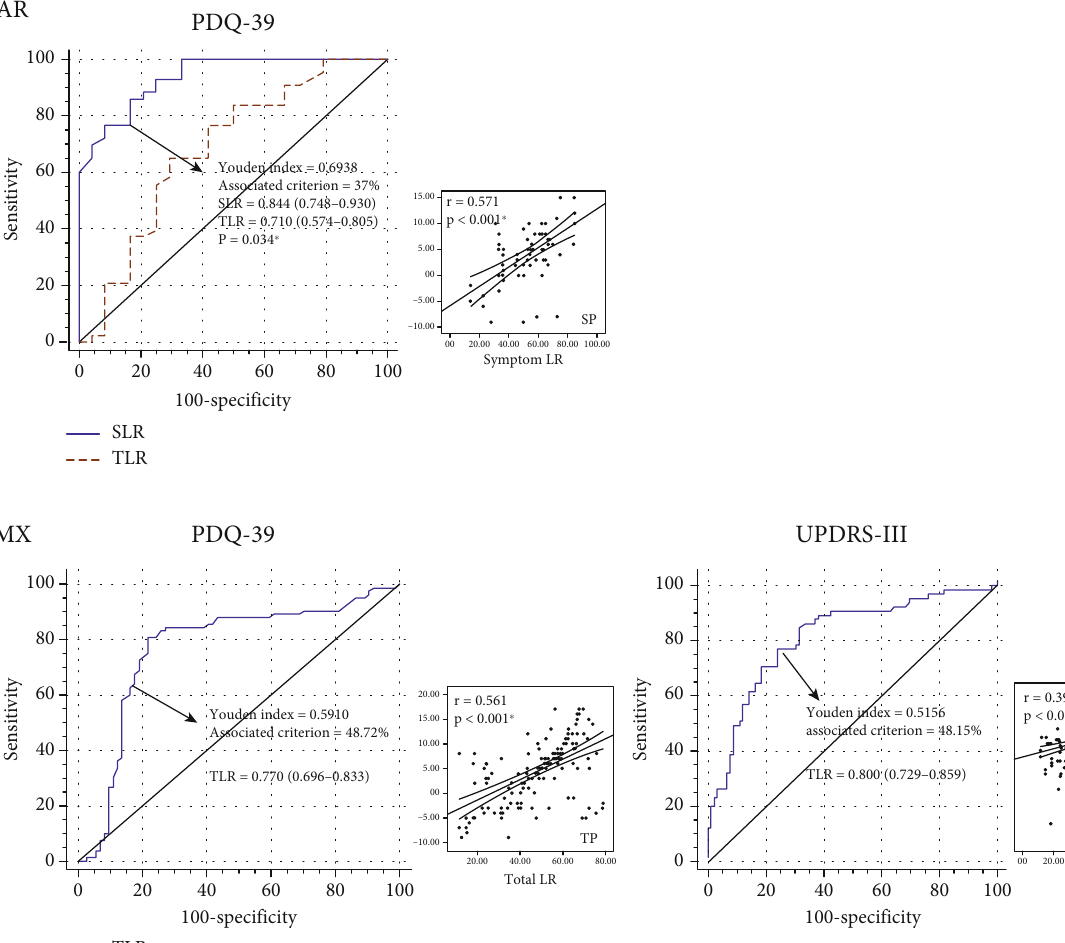
Figure 3: The receiver operating characteristic curves and scatter plots between TLR or SLR and postoperative STN-DBS bene fi ts among the two PD motor subtypes in the validation cohort. Signi fi cant correlations or comparisons are highlighted in bold and marked by ∗